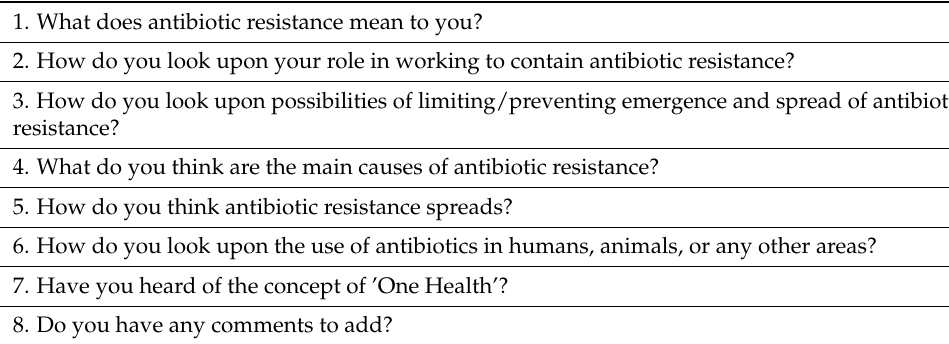
Table 2. Interview guide, main